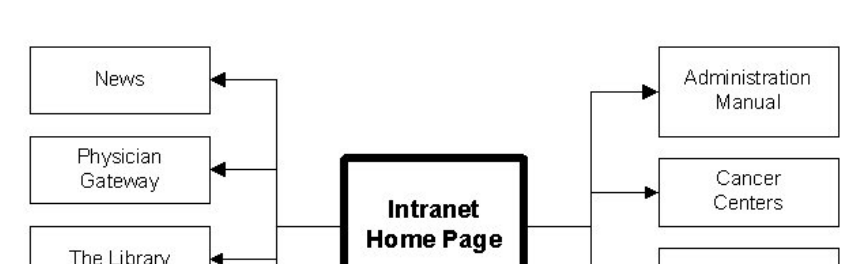
Figure 1. Example